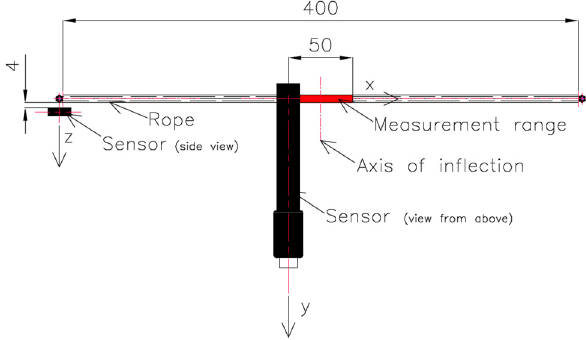
Figure 3: Procedure of the test with the SpinMeter - 3D sensor.